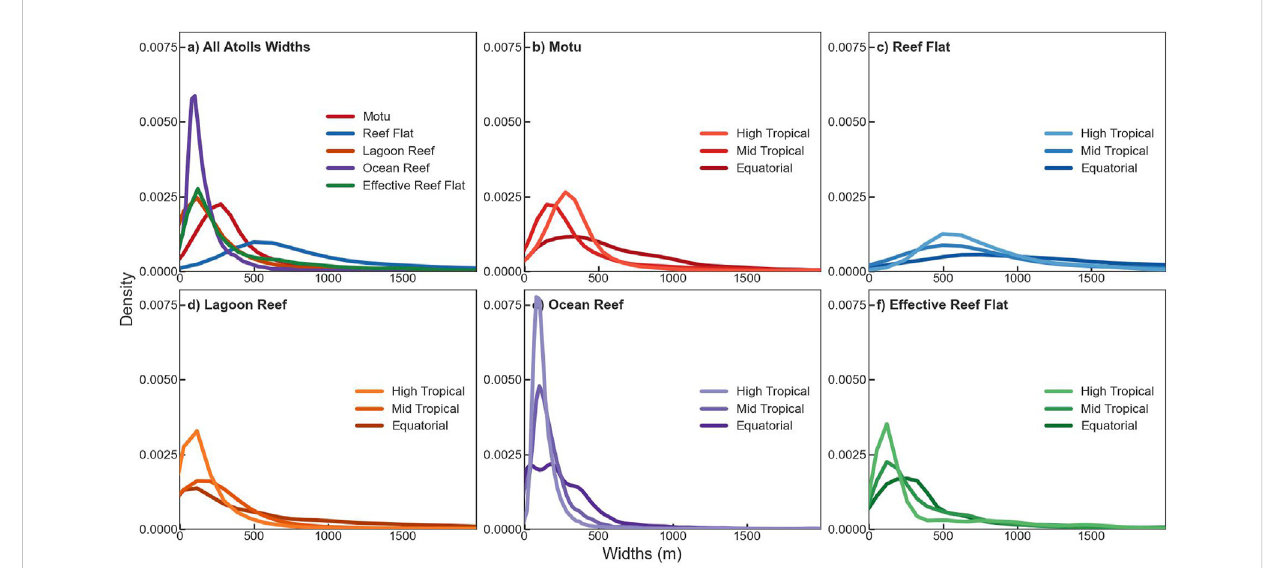
FIGURE 9 Densityfunctionofwidthmeasurementsforallatollsonaper-pointbasisgrouped bylatitude. (A) atollwidewidths, (B) motuwidth, (C) totalreef fl at width, (D) lagoon reef fl at width, (E) ocean reef fl at width, and (F) effective reef fl at width.